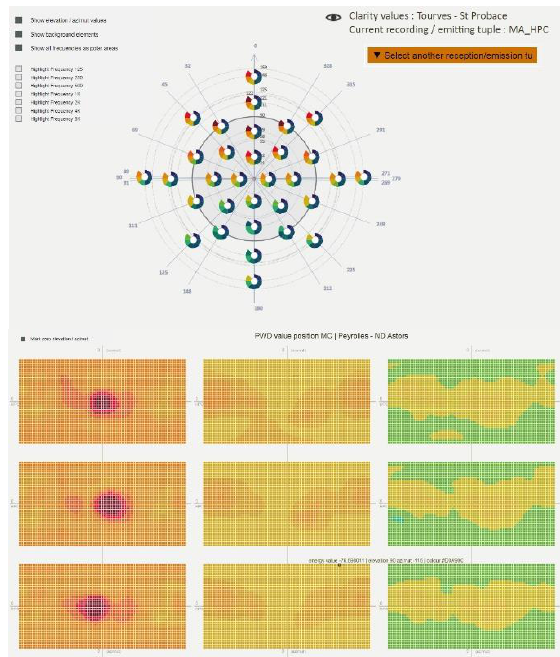
Figure 13 : 2D equivalents of the solutions designed in the context of the 3D Integrator: (top) the Allium 32 2D visualisation, with each sphere corresponding to one of the 32 capsules of the microphone (here projected on a flat surface, somehow like a map) and (bottom) a partial view of the eGrid visualisation (only three time frames, and three emission/reception points are